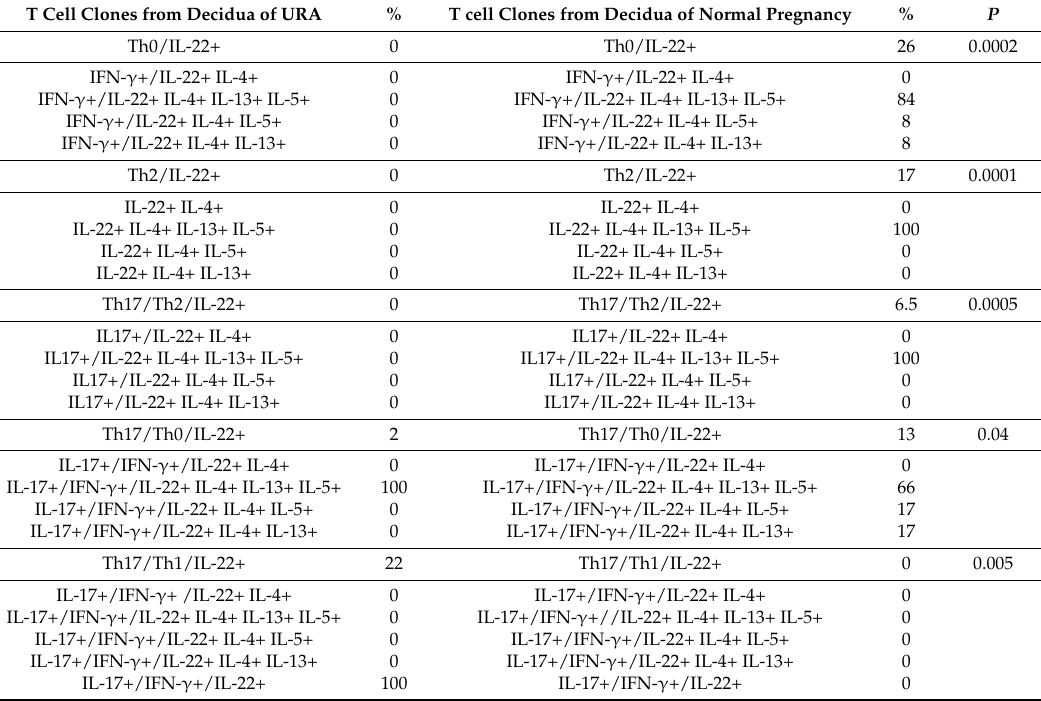
Table 1. CD4+ T subpopulations producing IL-22 in the decidua of those experiencing successful pregnancy and those experiencing URA. The percentage of the CD4+ T cell clones that produce IL-22 in the decidua of those experiencing successful pregnancy and those experiencing unexplained recurrent abortion (URA), which also produce Th2-type (IL-4, IL-5, IL-13), and/or Th1-type (IFN- γ ) and/or Th17-type (IL-17A) cytokines was determined. All the cytokines were measured by a multiplex bead-based assay in the supernatant of the CD4+ T cell clones. T Cell Clones from Decidua of